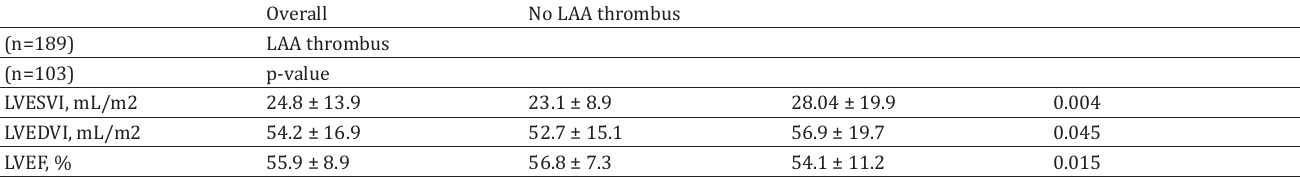
Comparison of volume measurements between patients with and without LAA thrombus according to CT (N=292)